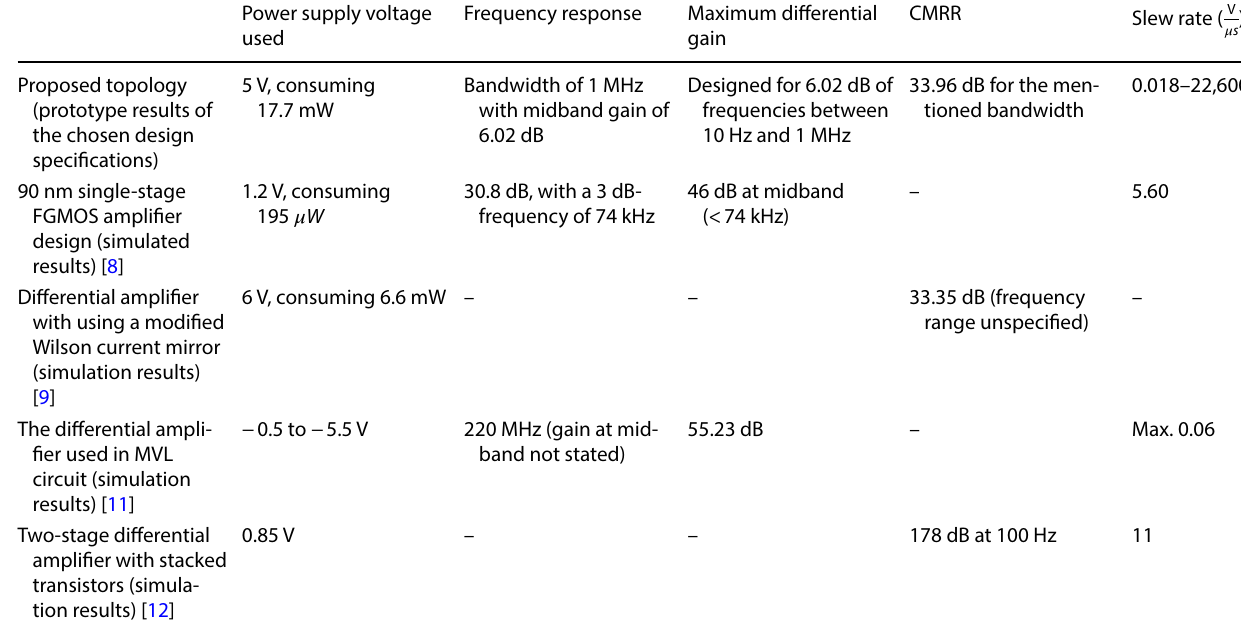
Table 4 Comparative parameters with the existing work Power supply voltage